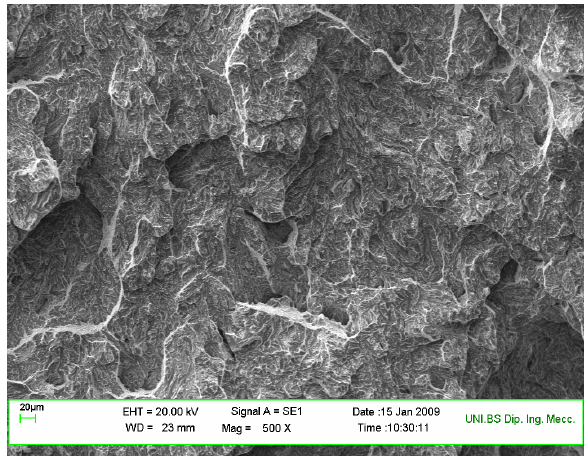
Figure 4. Fracture surface of the sample aged at 593 °C for 8 h, tested at − 150 °C.